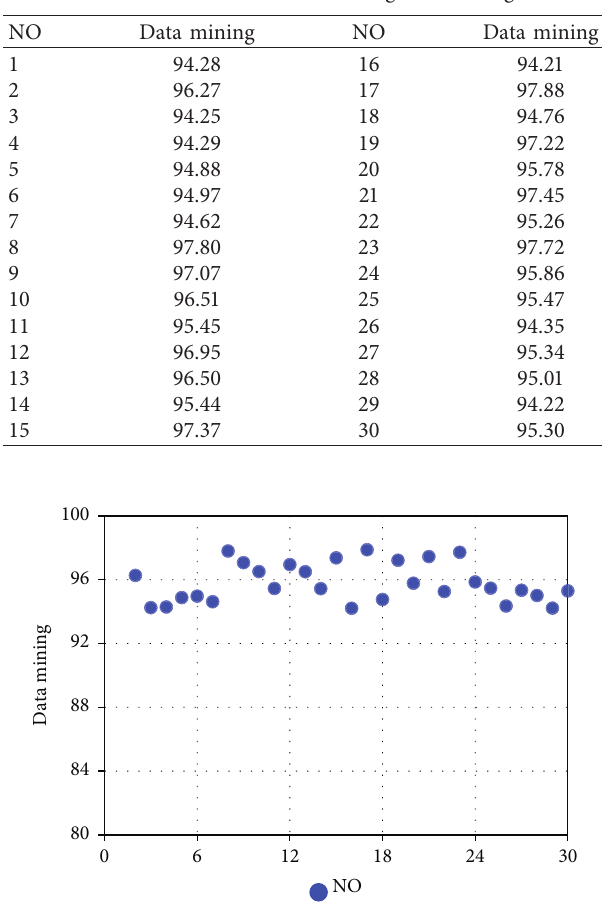
Table 1: The effect of accounting data mining.